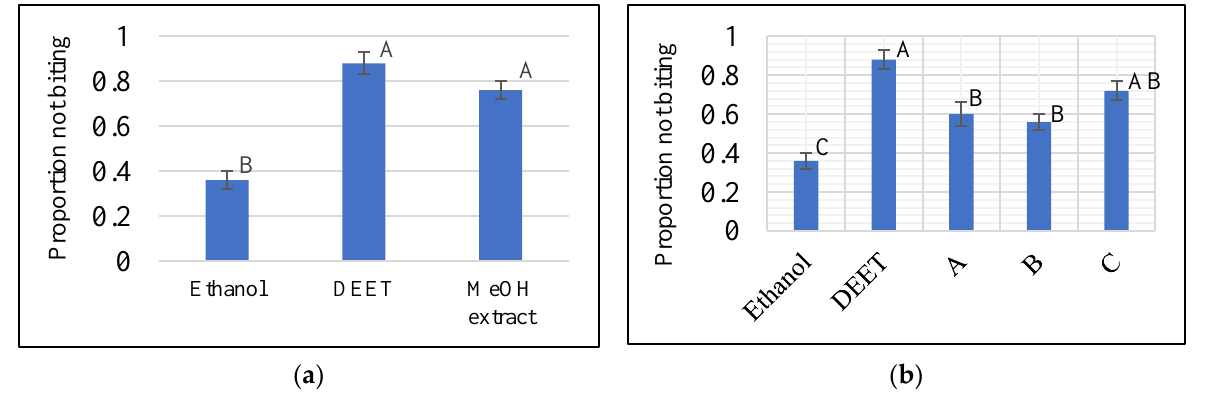
Figure 2. ( a ) Values of proportion not biting of methanolic extract and ( b ) subfractions of Stenaria nigricans and DEET against Aedes aegypti . The extract and subfractions were tested at 10 µg/cm 2 . DEET at 25 nmol/cm 2 was used at a positive control and ethanol was used as a solvent control. Means within each group followed by the same letter are not significantly different (Ryan-Einot- Gabriel-Welsch multiple range test ( p ≤ 0.05).